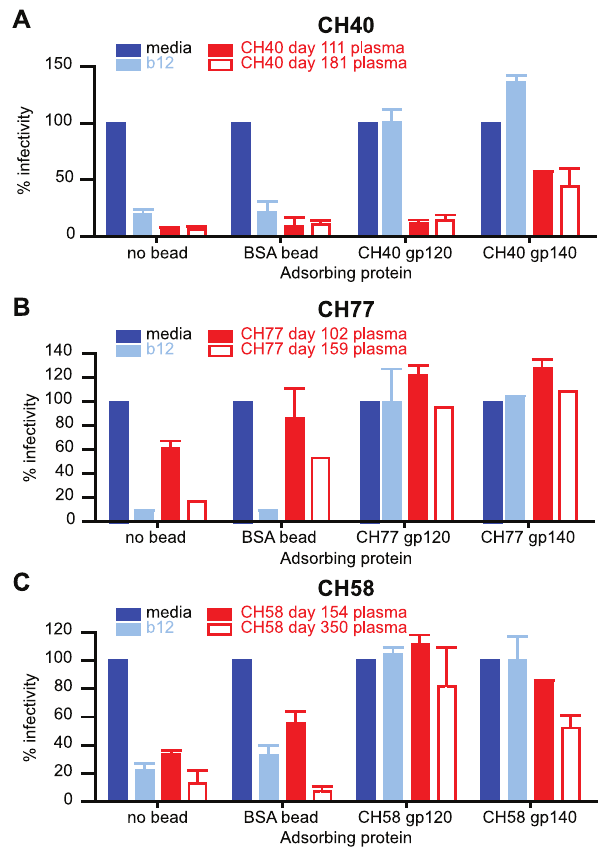
Figure 5. Adsorption of plasma Nabs by autologous T/F Env monomers and trimers. Plasma from CH40 (A), CH77 (B), and CH58 (C) was incubated with magnetic-bead bound gp120 or tethered gp140 protein corresponding to the T/F sequence from each subject. Beads were removed and neutralization assessed by TZM-bl assay (BSA, bovine serum albumen; b12 broadly neutralizing mAb positive control). Results are the mean + / 2 SD of three independently performed experiments each performed in